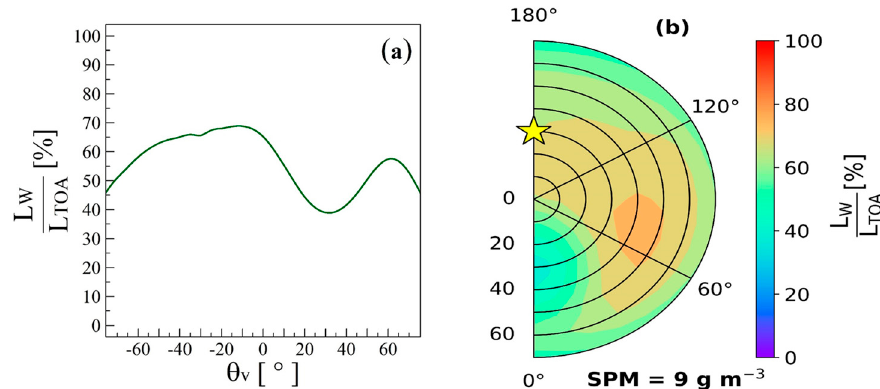
Figure 2. ( a ) Variation of the ratio L w /L TOA (in %) as a function of the viewing zenith angle θ v in the principal plane at 560 nm for the benchmark case of simulation (Table 1). Positive values of θ v are used for the specular half-plane while negative values are used for the backscattering half-plane; ( b ) Polar diagram of the angular variation of L w /L TOA (in %) at 560 nm; the relative azimuth angle φ OSOAA is represented by straight lines while the viewing zenith angle θ v is represented by circles. The position of the Sun ( φ OSOAA = 180° and θ v = 30°) is indicated by the yellow star.